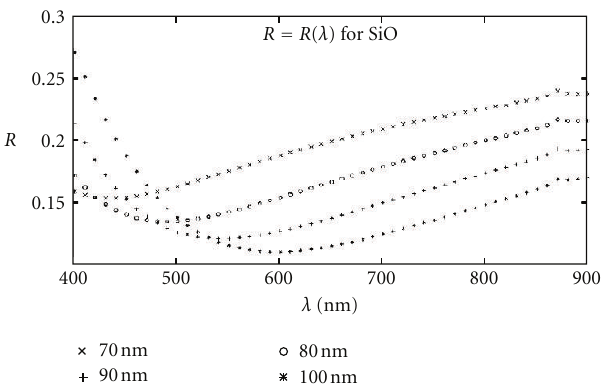
Figure 4: Simulation of the reflectance for a solar cell with QW structure, for a SiO antireflecting